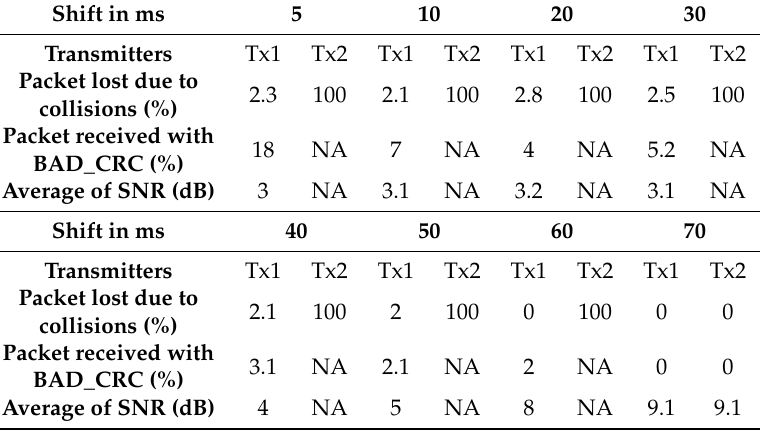
Table 3. Statistics for collided packets for the case when the interferer has the same RSSI as the interfered transmission for the second setting from Table 1. NA stands for Not